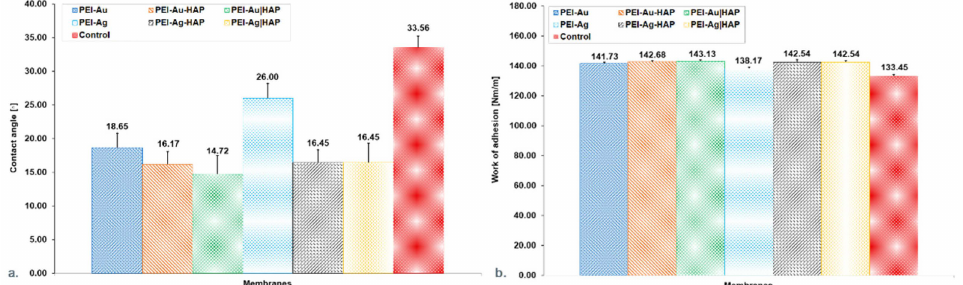
Figure 2. ( a )—The water contact angle of the composite membranes. ( b )—Work of adhesion of the composite membranes. Key to symbols: I. Membranes with AgNPs: polyethyleneimine membrane with AgNPs (PEI-Ag); bilayer consisting of polyethyleneimine with AgNPs and hydroxyapatite (PEI-Ag|HAP) and membrane build of polyethyleneimine with AgNPs and HAP complex (PEI-Ag- HAP). II. Membranes with AuNPs: polyethyleneimine membrane with AuNPs (PEI-Au); bilayer consist of polyethyleneimine with AuNPs and hydroxyapatite (PEI-Au|HAP) and membrane build of polyethyleneimine with AuNPs and HAP complex (PEI-Au-HAP). The values are presented as mean ±